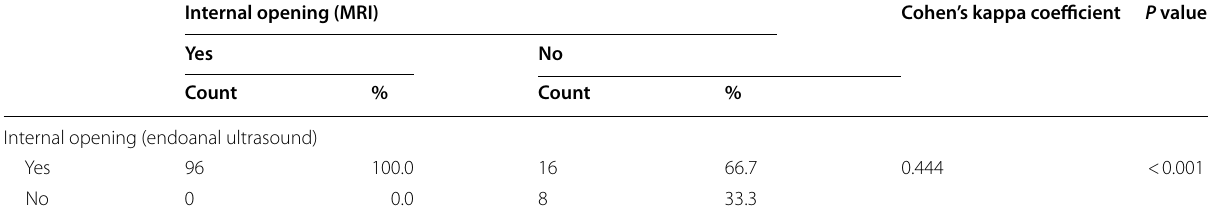
Table 3 Comparative study between endoanal ultrasound and MRI in detection of the internal opening Internal opening (MRI)